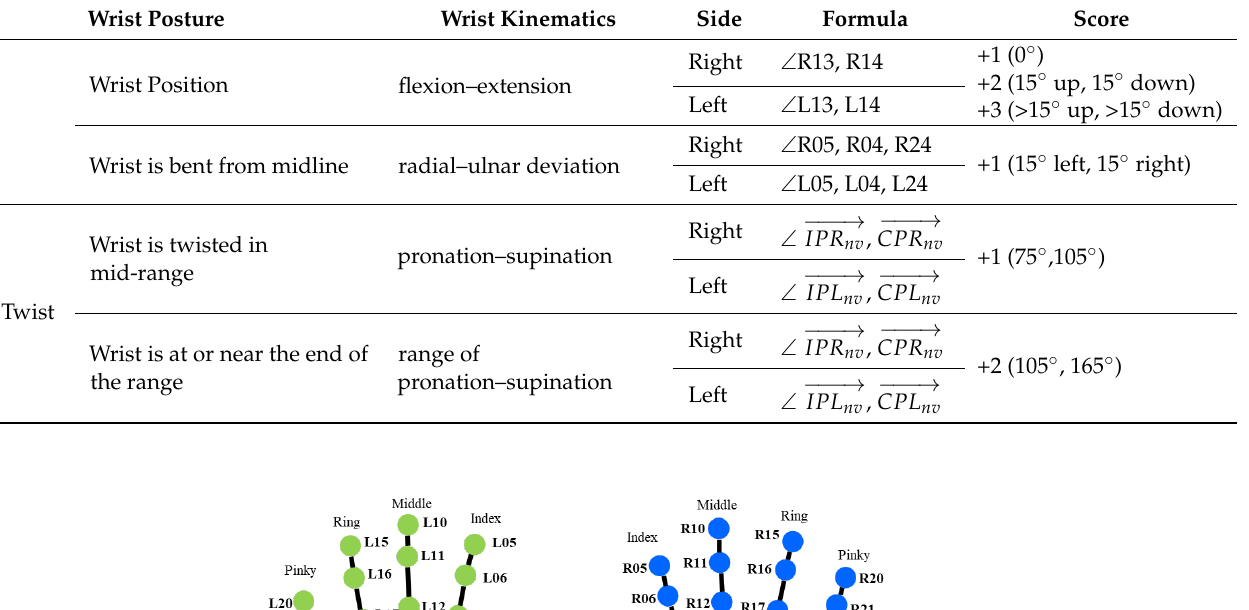
Table 3. RULA wrist posture scoring criteria.